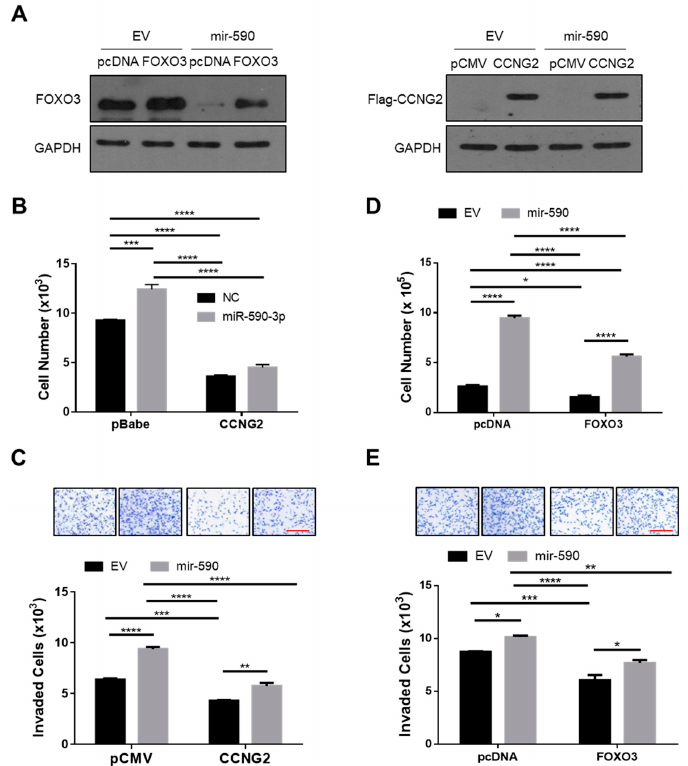
Figure 4. Overexpression of CCNG2 and FOXO3 reversed the effects of miR-590-3p on cell proliferation and invasion . ( A ) Confirmation of FOXO3 and CCNG2 overexpression. SKOV3.ip1 cells stably overexpressing mir-590 or its empty vector (EV) were transiently transfected with FOXO3 (left), CCNG2 (right) , or their corresponding control vectors. Western blot analyses were performed using FOXO3 or Flag (to detect CCNG2) antibody. ( B ) Overexpression of CCNG2 attenuated the effect of miR-590-3p on cell proliferation. SKOV3.ip1 cells stably transfected with CCNG2 or its control vector pBabe-puro were transiently transfected with either miR-590-3p or a non-targeting control oligo (NC). The effect of miR-590-3p was blocked by CCNG2 overexpression. ( C ) The overexpression of CCNG2 reduced the effect of mir-590 on cell invasion. ES-2 cells stably expressing mir-590 or its empty vector (EV) were transiently transfected with either CCNG2 or its empty vector pCMV, and cell invasion was determined. ( D ) Transient transfection of FOXO3 into SKOV3.ip1 stably expressing mir-590 or EV decreased cell proliferation and ( E ) cell invasion. Red scale bar (C and E) = 25µm. Data represent the mean ± SEM ( n = 3). Statistical analyses were performed using two-way ANOVA/Student–Newman–Keuls test. * p < 0.05, ** p < 0.01, *** p < 0.001, **** p < 0.0001.